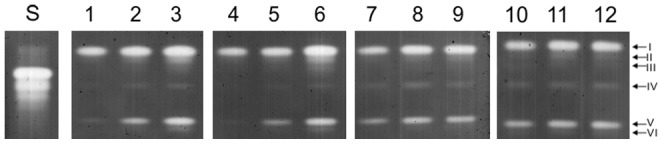
Non-denaturing-PAGE for SOD activity.Patterns presented by E. coli DH5-α in MM (lines 1, 2 and 3) and in the MMM (lines 4, 5 and 6), -C (lines 7, 8 and 9), and -CM (lines 10, 11 and 12) treatments, at periods of 30 min., 3 h and 6 h, respectively.